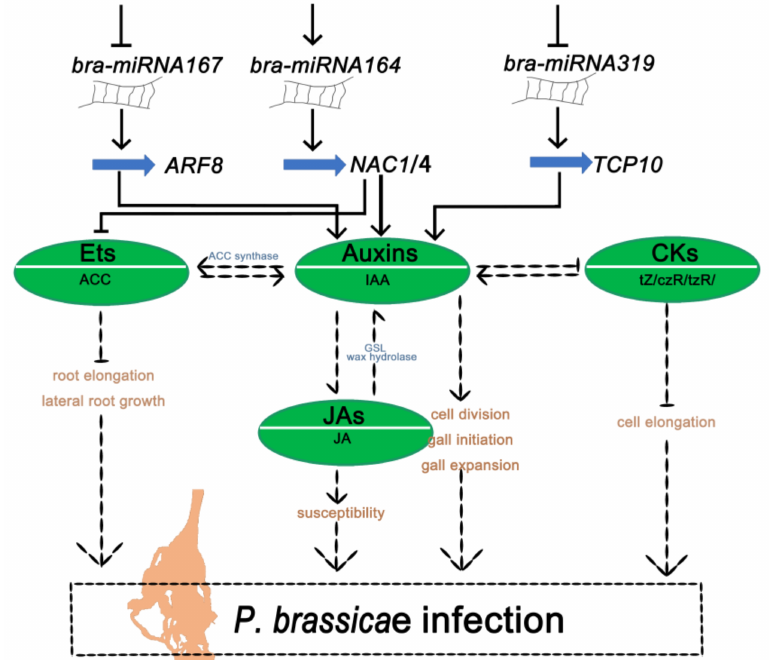
Figure 8. Proposed model of infection response to P. brassicae in B. rapa of the S-line based on hormonal regulation after pathogen